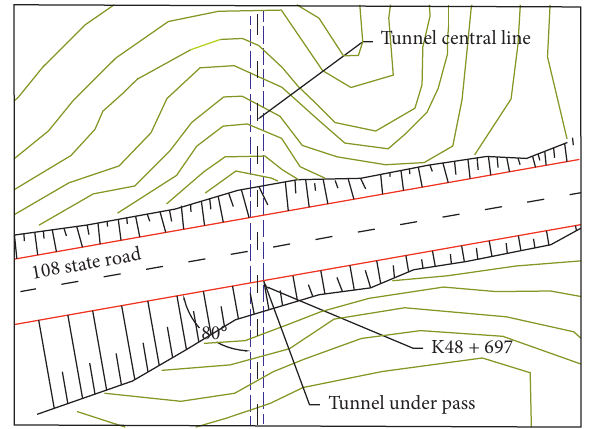
Figure 1: Tunnel under the National Road 108 Plan.